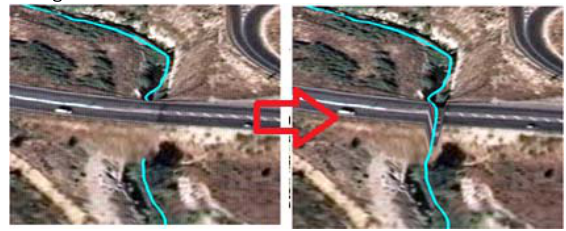
Figure 9. Obstacles correction 1 (bridges from cartography) Obstacles correction 2 (bridges from LiDAR)